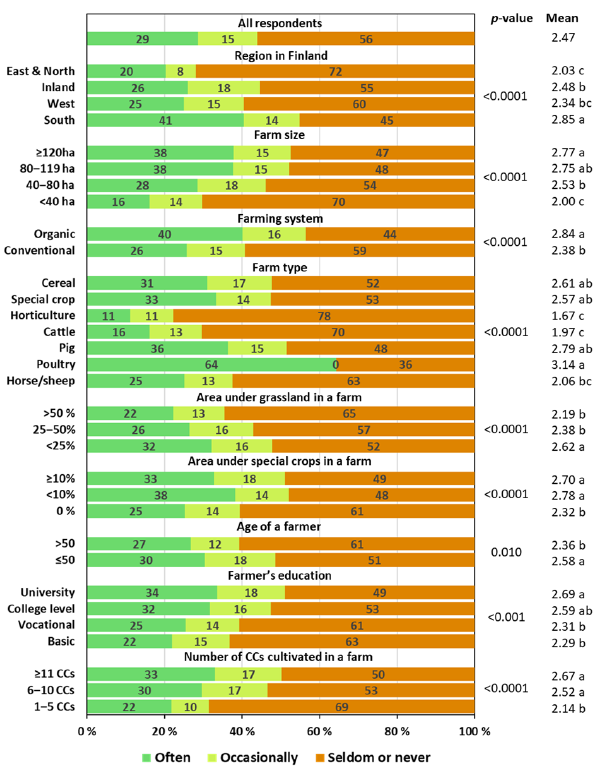
Figure 12. The distribution and means of farmers’ answers to the statement: “I have invested in special machinery to make the cultivation of CCs more successful”, (N = 1130) depending on farm and farmer characteristics (CCs, cover crops).